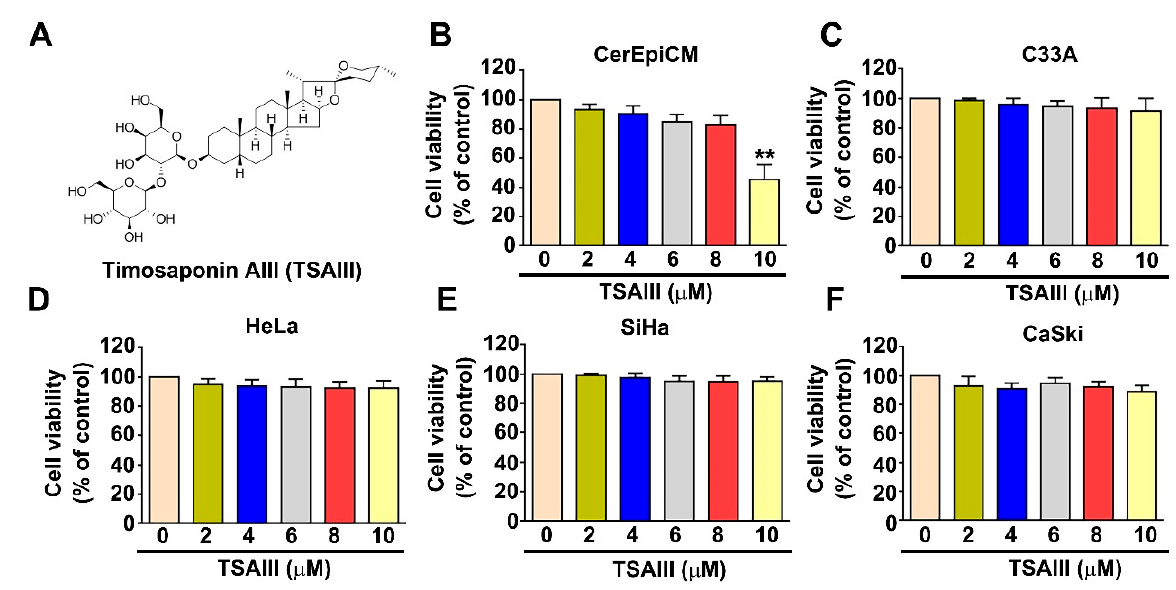
Figure 1. Effect of TSAIII on viability and cytotoxicity of human cervical cancer cells. ( A ) Structure of Timosaponin AIII (TSAIII). ( B ) CerEpi cells (human normal cervical epithelial cells). ( C – F ) C33A, HeLa, SiHa and CaSki cells (human cervical cancer cells) were exposed to various concentrations (0, 2, 4, 6, 8 and 10 µM) of TSAIII for 24 h and then measured via MTT assay to observe cell viability (mean ± SE, n = 3). ** p < 0.01.